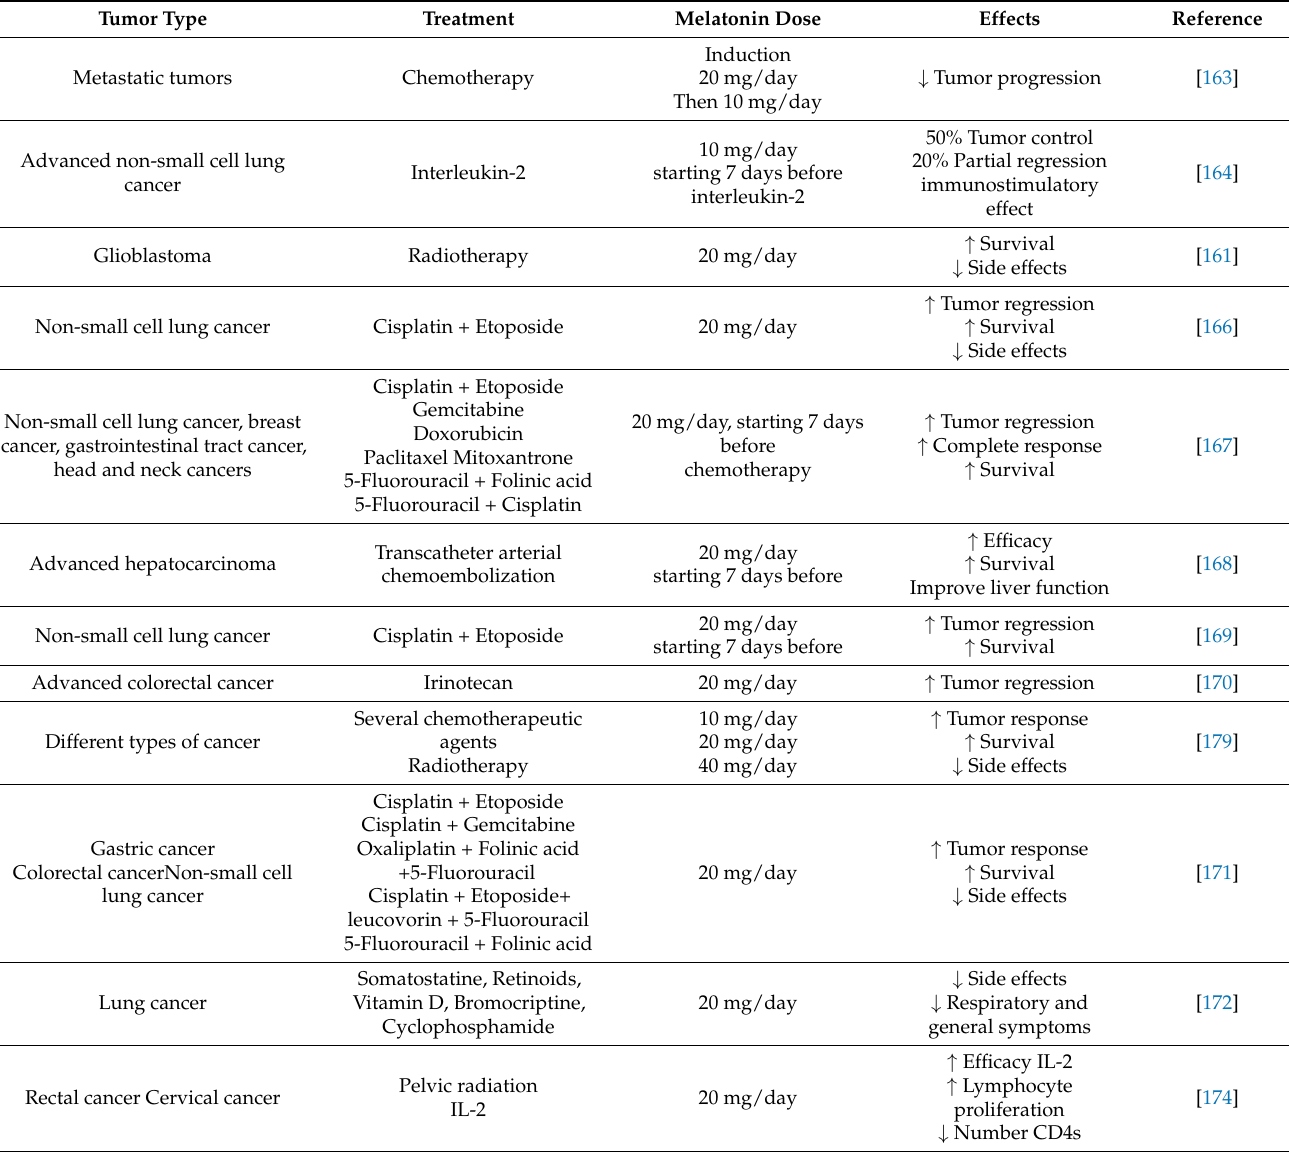
Table 2. Clinical trials with melatonin as sensitizer to other antitumor